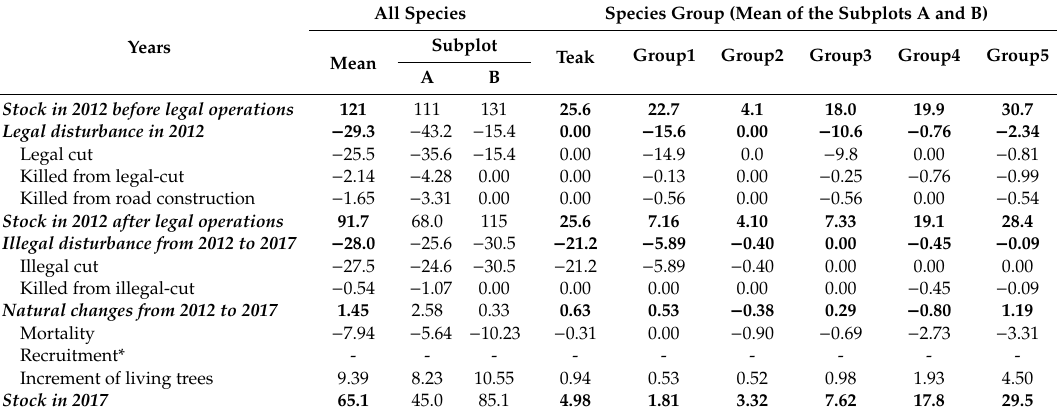
Increment of living